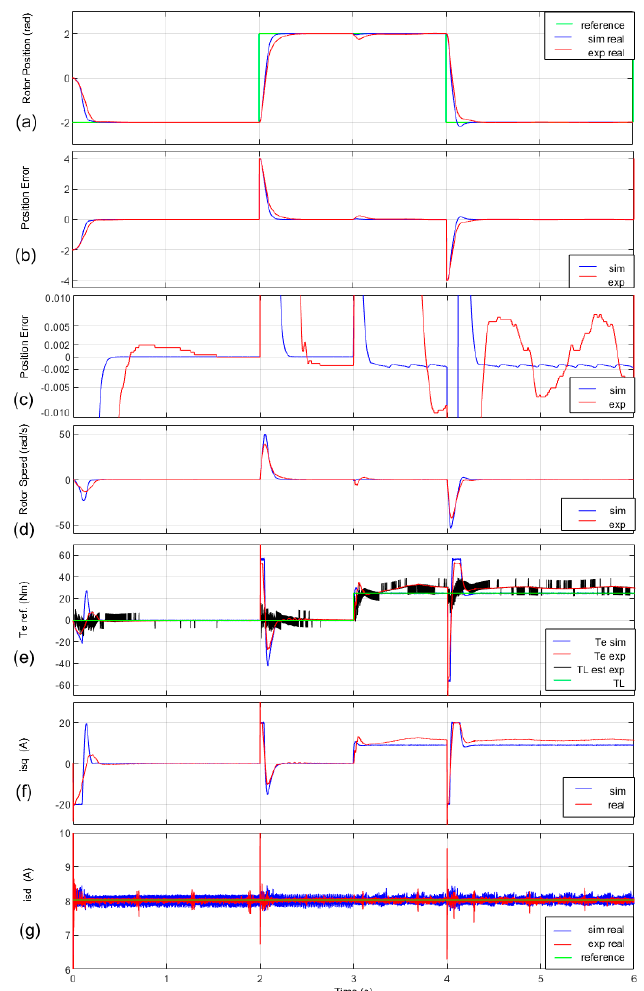
Figure 7. Simulation and experimental tests’ performances employing the D1 design for the IM